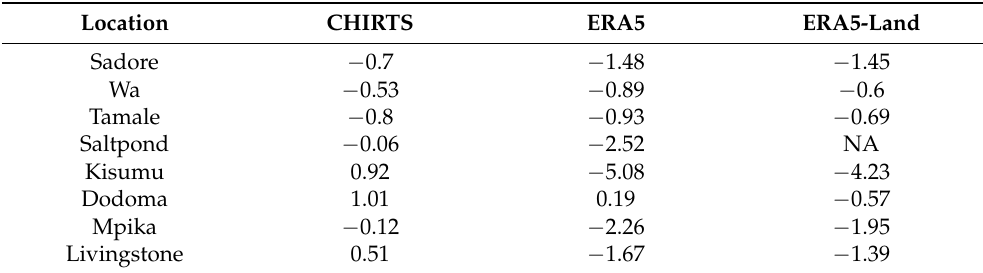
Table 8. Bias between the annual extreme maximum temperature from the station data and the three gridded